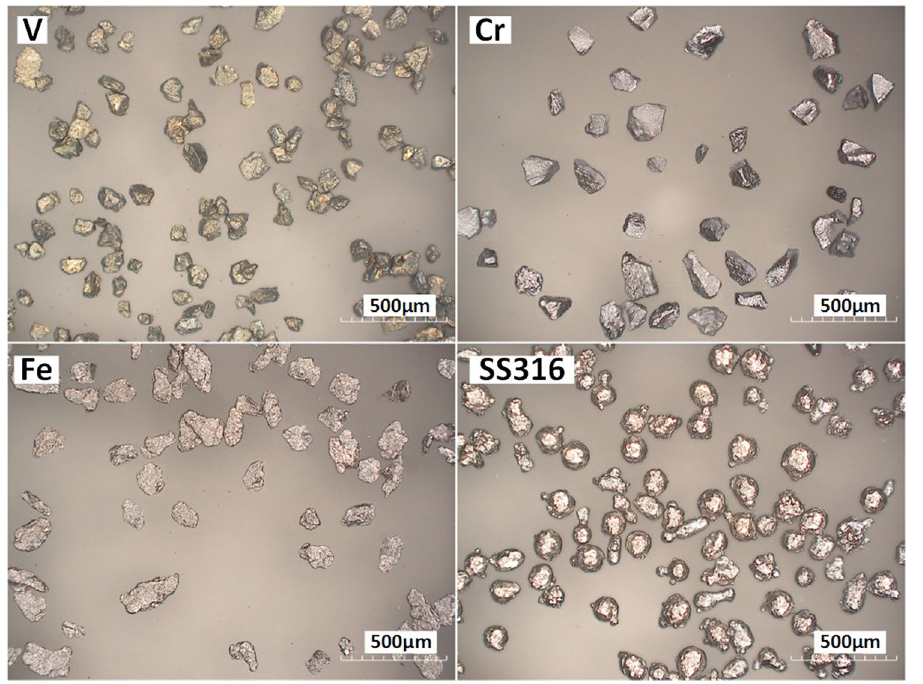
Figure 17. Optical Micrograph of the four types of